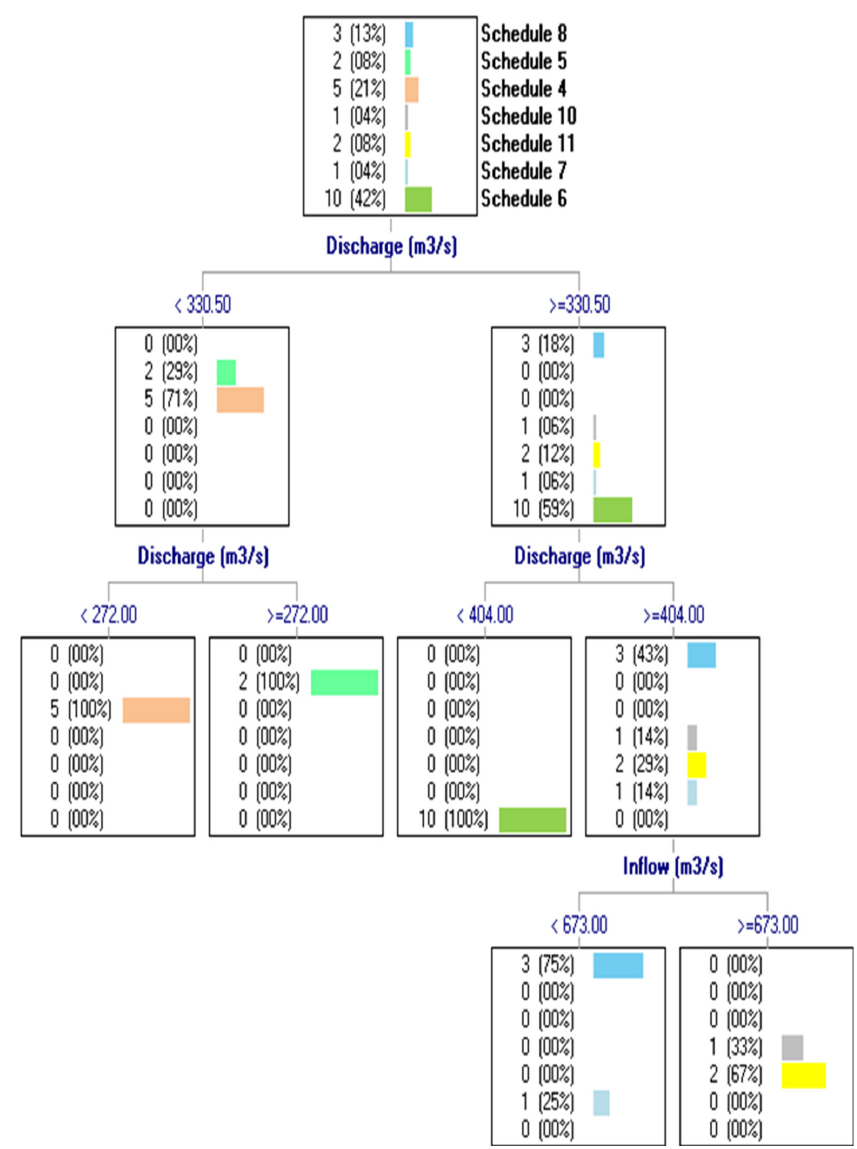
Figure 6. Decision tree of Tianshengqiao plant 2 generated by C4.5 for the summer